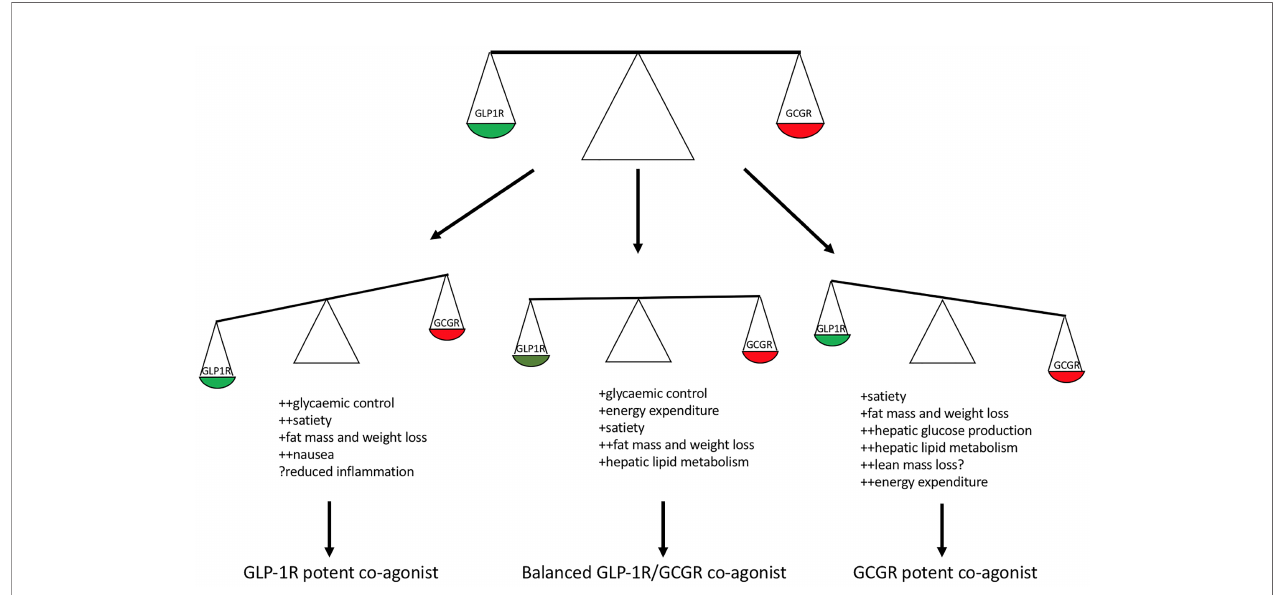
FIGURE 2 | Balance of GLP-1R and GCGR potency within a co-agonist and predicted clinical effects. Glucagon receptor potent co-agonists predicted to result in enhanced weight loss due to increased energy expenditure however possible loss of lean mass and increased hepatic glucose production. GLP-1R potent co-agonists predicted to confer enhanced weight loss and glycaemic control with risk of gastrointestinal side effects. A balanced GLP-1R/GCGR co-agonist with respect to in vitro cAMP stimulation predicted to enhance glycaemic control and healthy fat mass